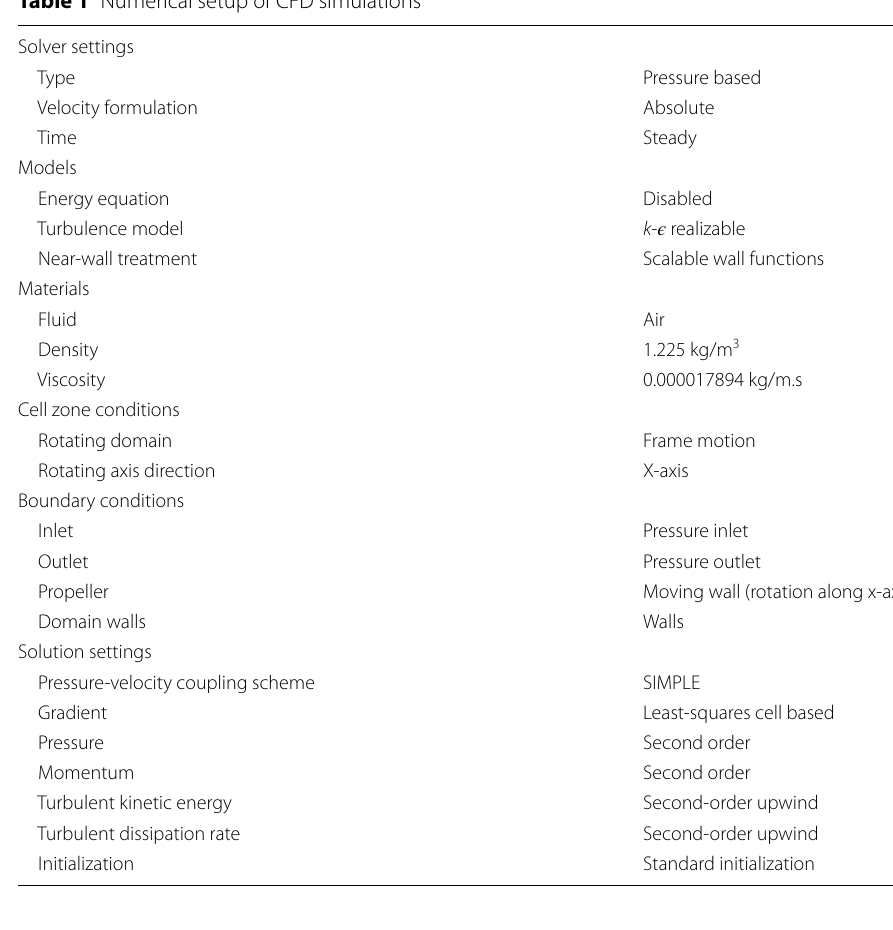
Table 1 Numerical setup of CFD simulations